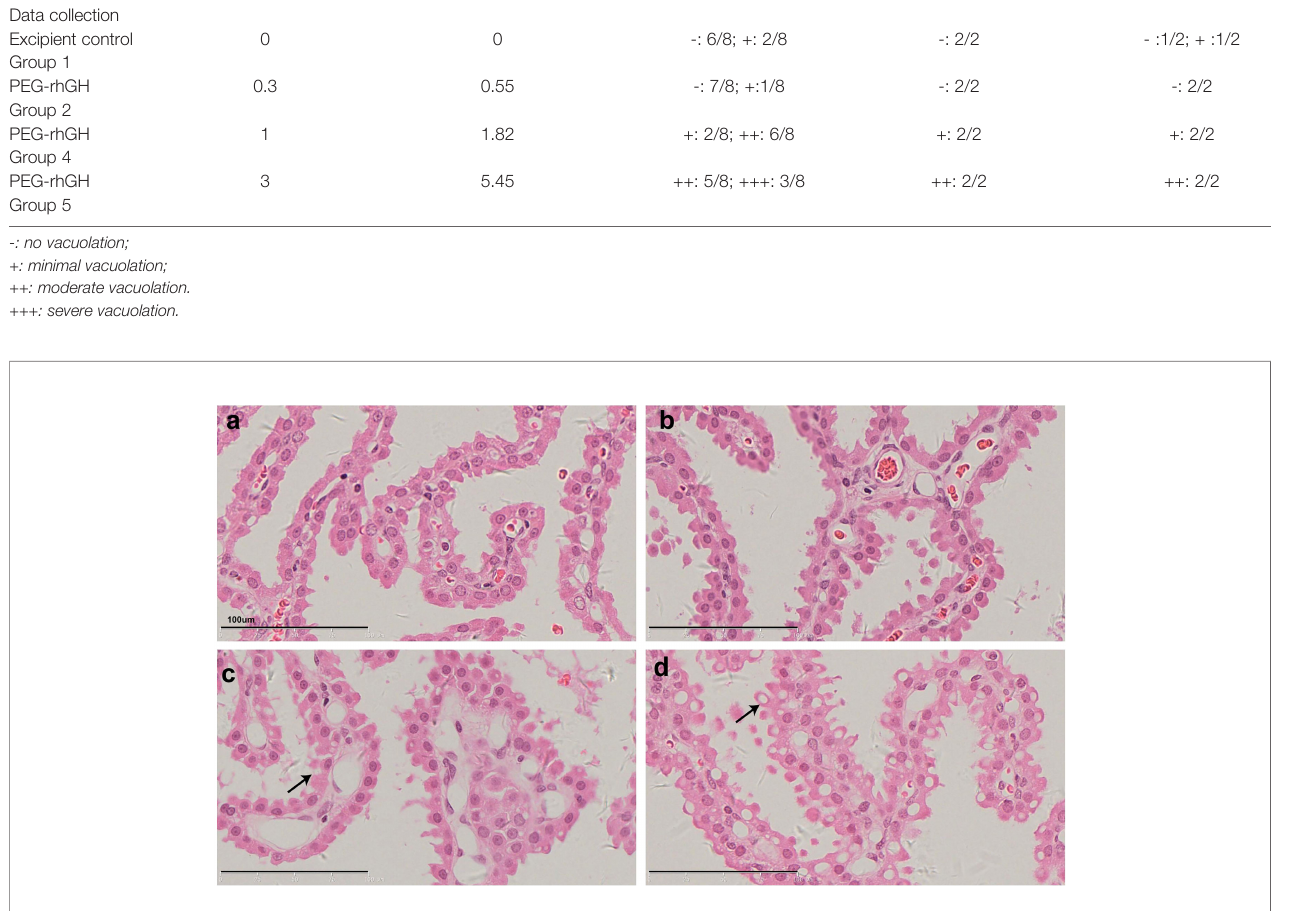
FIGURE 2 | H&E staining of cynomolgus monkeys CP epithelium with 52-week administration of Jintrolong. (A) Excipient control group. (B) Jintrolong group with 0.3 mg/kg/week administration. (C) Jintrolong group with 1 mg/kg/week administration. (D) Jintrolong group with 3 mg/kg/week administration. Arrows in panels (C) and (D) indicate representative cytoplasmic